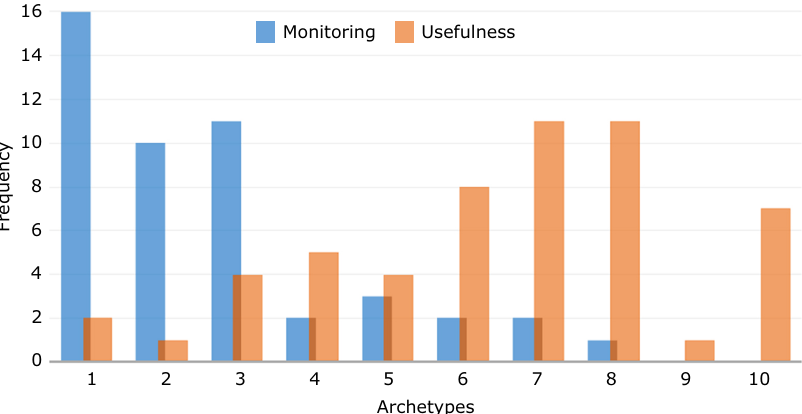
Fig. 5. Level of monitoring and